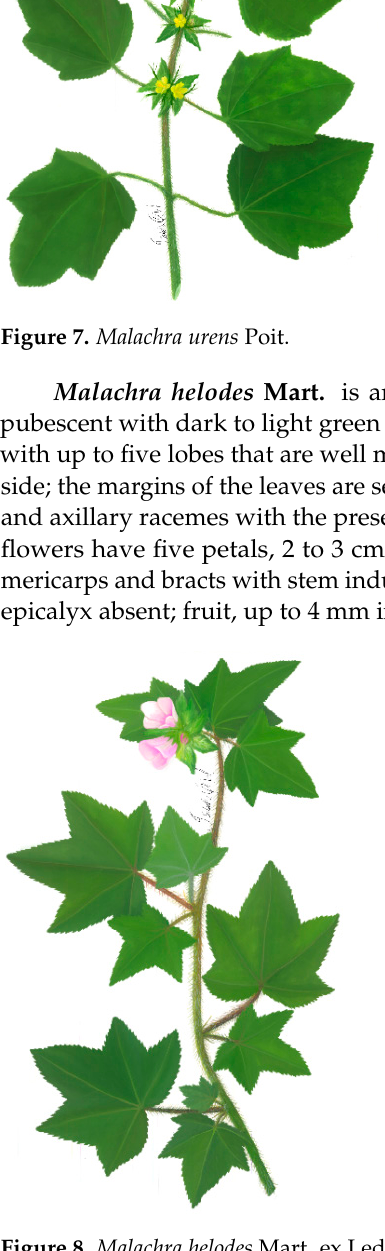
Figure 8. Malachra helodes Mart. ex Ledeb. & Alderstam. 5. Geographical Distribution of the Genus Malachra L.